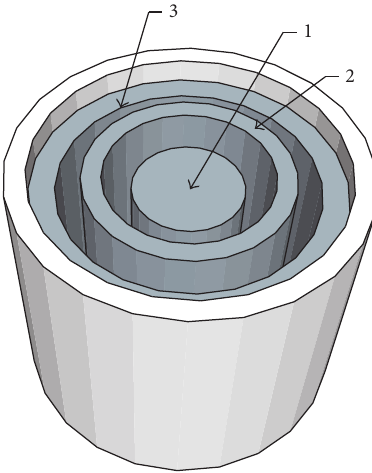
Figure 1: Schematic diagram of the tester.